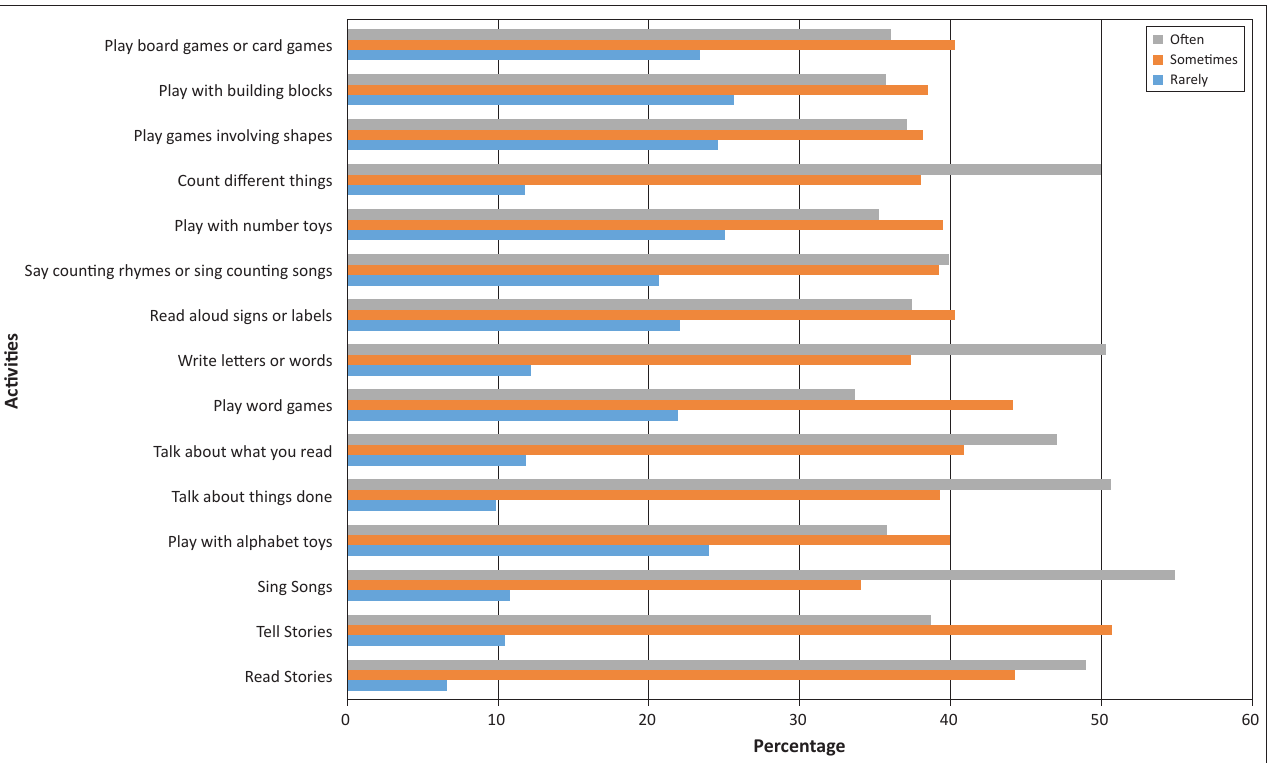
FIGURE 2: Frequency of early home literacy activities reported by parents.